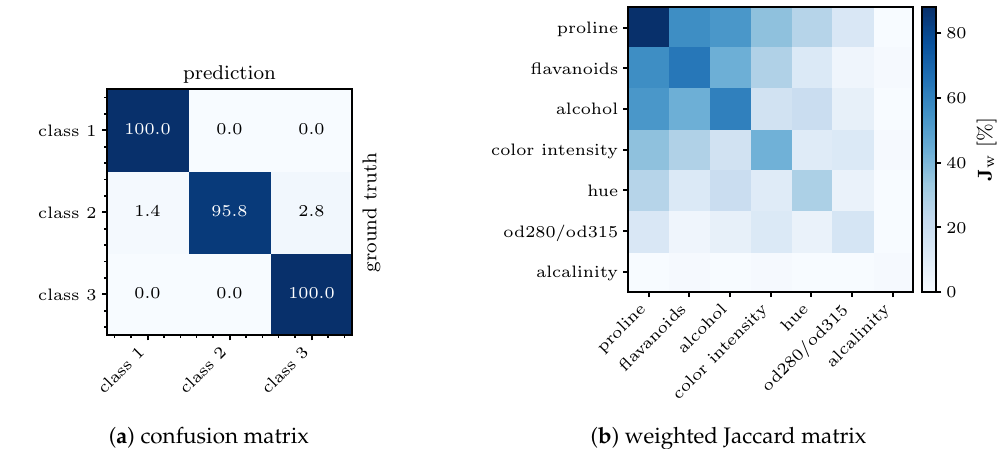
Figure 11. Different evaluations of the effectiveness of FeaSel-Net. A confusion matrix ( a ) for a test set te X consisting of training and validation samples with only three features shows how good the classification result of a single selection is, whereas the weighted Jaccard matrix ( b ) shows the inter-dependencies of the features in 100 FS